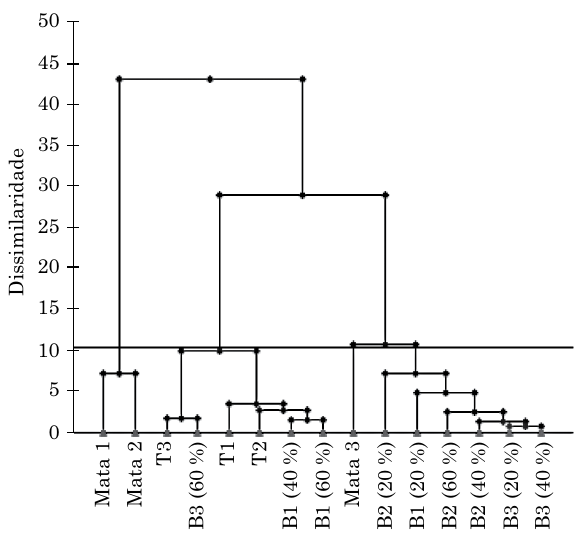
Figura 10. Dendrograma representando a dissimilaridade entre o grupo da testemunha e o do cultivo de figo. T1, T2, T3 correspondem ao sistema com a testemunha, B1(20 %), B2 (20 %), B3 (20 %) ao sistema com biofertilizante 20 %, B1(40 %), B2 (40 %), B3 (40 %) ao com biofertilizante 40 %, B1(60 %), B2 (60 %), B3 (60 %) ao com biofertilizante 60 % e M1, M2, M3 à mata secundária, todos, respectivamente, às camadas de 0,0-0,1, 0,1-0,2 e 0,2-0,3